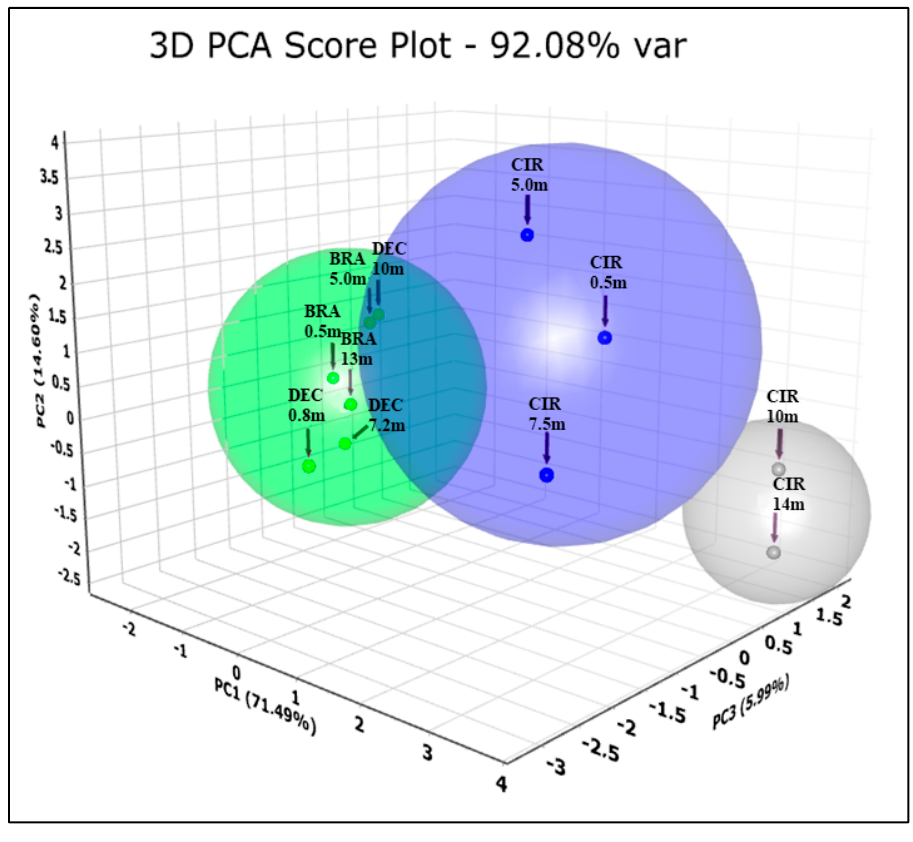
Figure 2. Principal component analysis showing the grouping of the diffractograms. Group 1: green sphere (BRA0.5m, BRA5.0m, BRA13m, DEC0.8m, DEC7.2m, and DEC10m); Group 2: blue sphere (CIR0.5m, CIR5.0m, and CIR7.5m); Group 4: gray sphere (CIR10m and CIR14m).